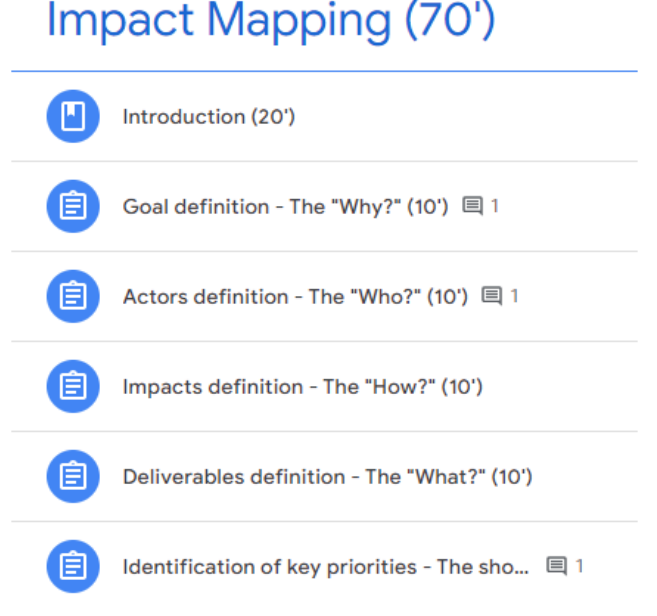
Figure 6. Impact mapping